Question: What style of plot is this figure drawn as?
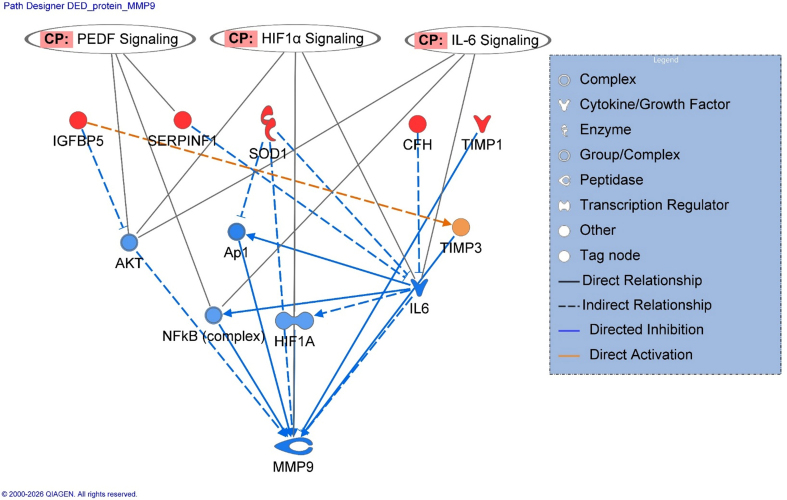
Answer: line